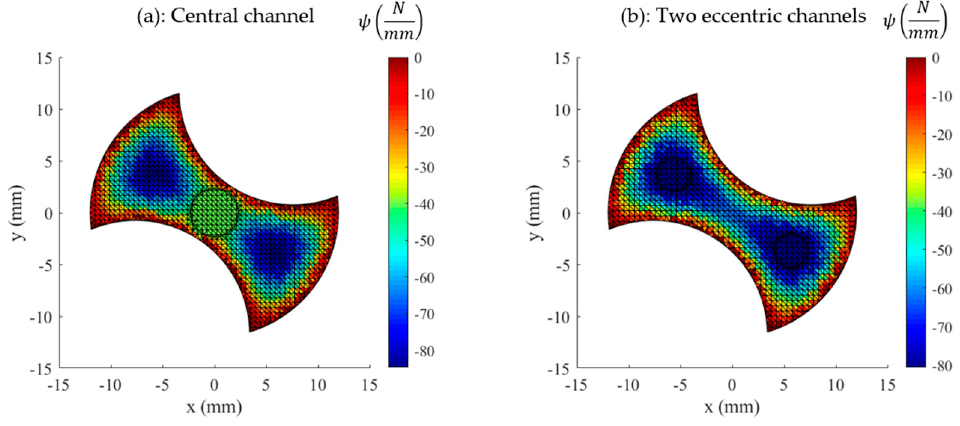
Figure 4. Prandtl’s stress function ( 𝜓 ), for drills with ( a ) a single central coolant channel and ( b ) twin eccentric channels placed at the minima shown in Figure 3.